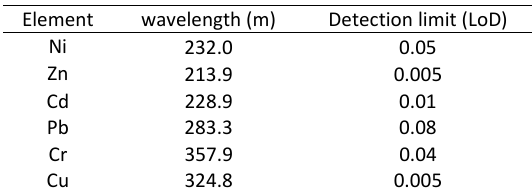
Table 2: Wavelengths and detection limit of the calibrated instrument used